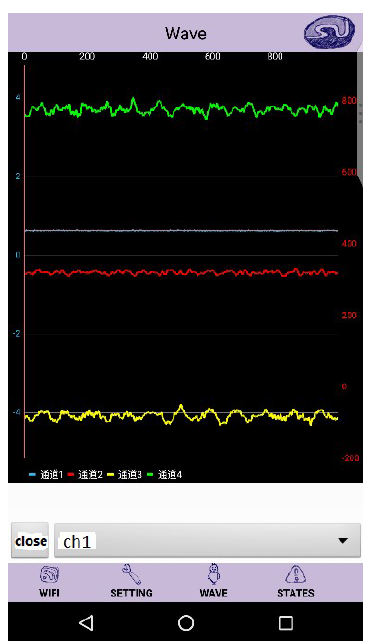
Figure 5. Three-channel